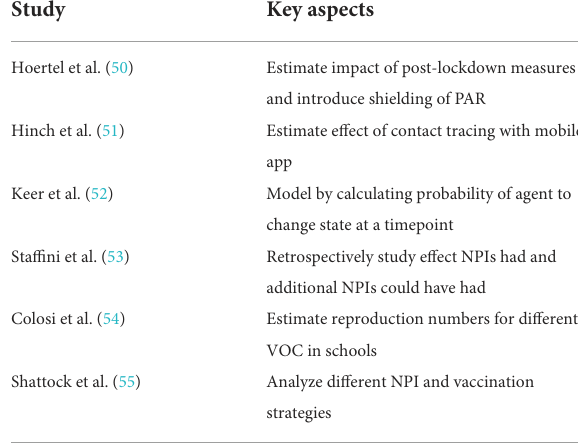
TABLE 4 Included studies covering spatio-temporal monitoring of disease spread with agent-based modeling approaches and their key